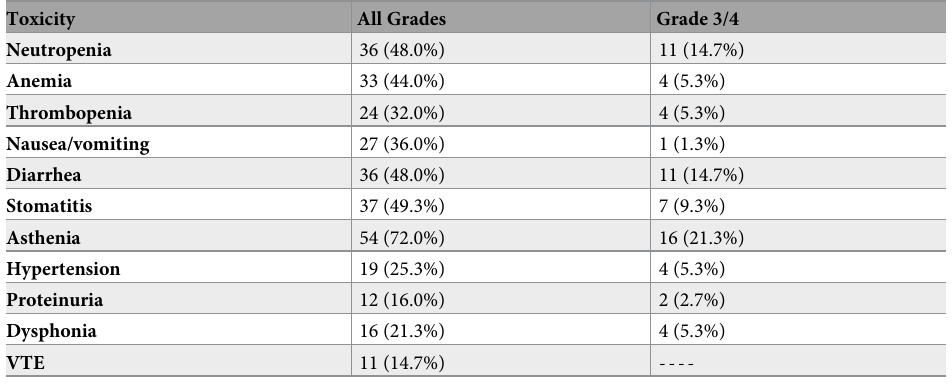
Table 3. Summary of the most common all grade and grade 3/4 adverse events.